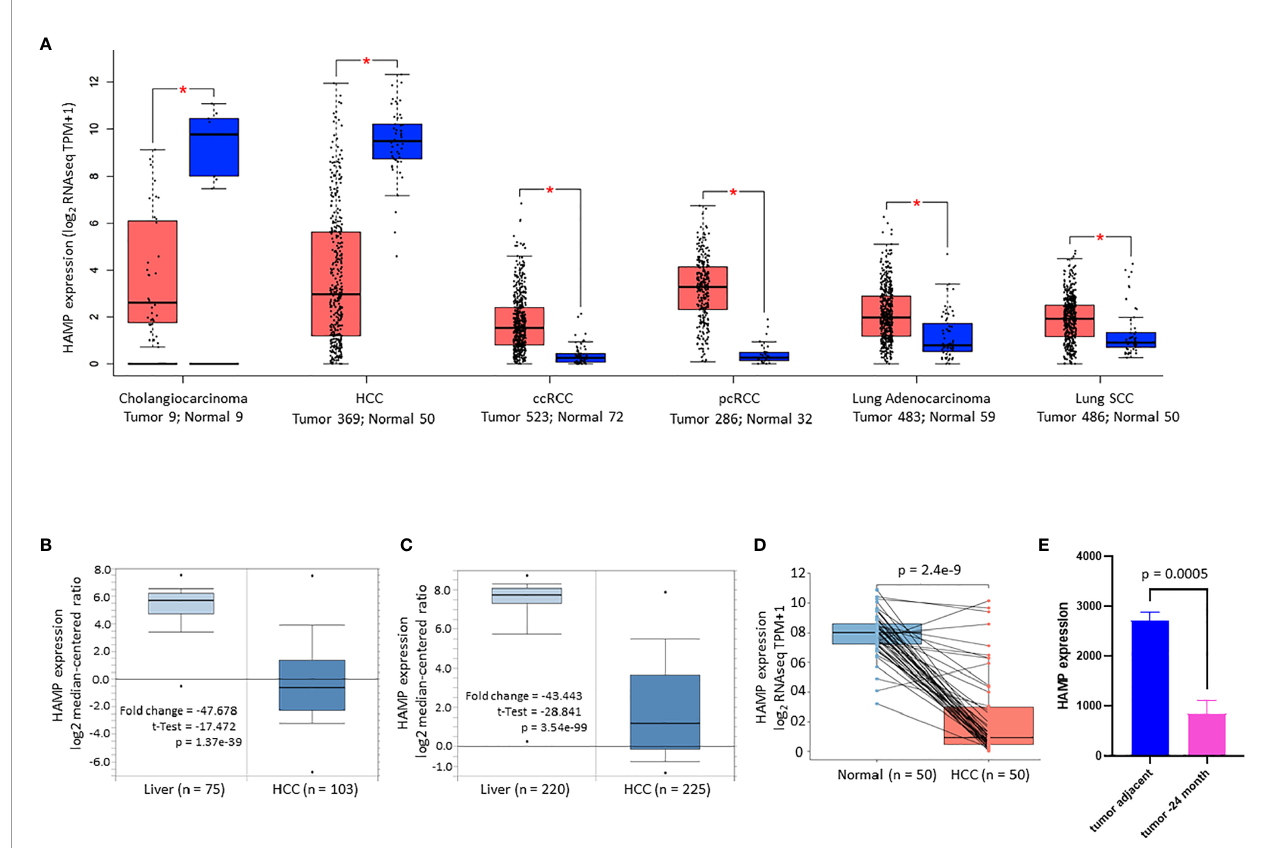
FIGURE 1 | Hepcidin expression is drastically reduced in liver cancers. (A) Hepcidin expression pro fi les in human cancers were compared with normal tissues using the TCGA dataset on the GEPIA platform (19). Case numbers in each group were listed at the bottom of the fi gure. The asterisks indicate a statistically signi fi cant difference (p < 0.05, Wilcoxon rank-sum test). HCC, hepatocellular carcinoma; ccRCC, clear cell renal cell carcinoma; pcRCC, papillary cell renal cell carcinoma; Lung SCC, lung squamous cell carcinoma. (B, C) Hepcidin expression in liver cancers was assessed in two cDNA microarray datasets (37, 38). The comparison between normal and malignant liver tissues was conducted using a Student t -test. (D) Hepcidin expression in human liver cancers was compared with matched tumor-adjacent benign tissues in 50 cases from the TCGA project. The p-value was from a paired t -test. Note: only three cases showed a slight increase in cancer tissue compared to the benign compartment. (E) Hepcidin expression data was derived from the GDS2006 dataset in the Tnixp -de fi cient mice with spontaneous liver cancer (30). Hepcidin expression levels were normalized with ACTB gene levels as an internal control (n =